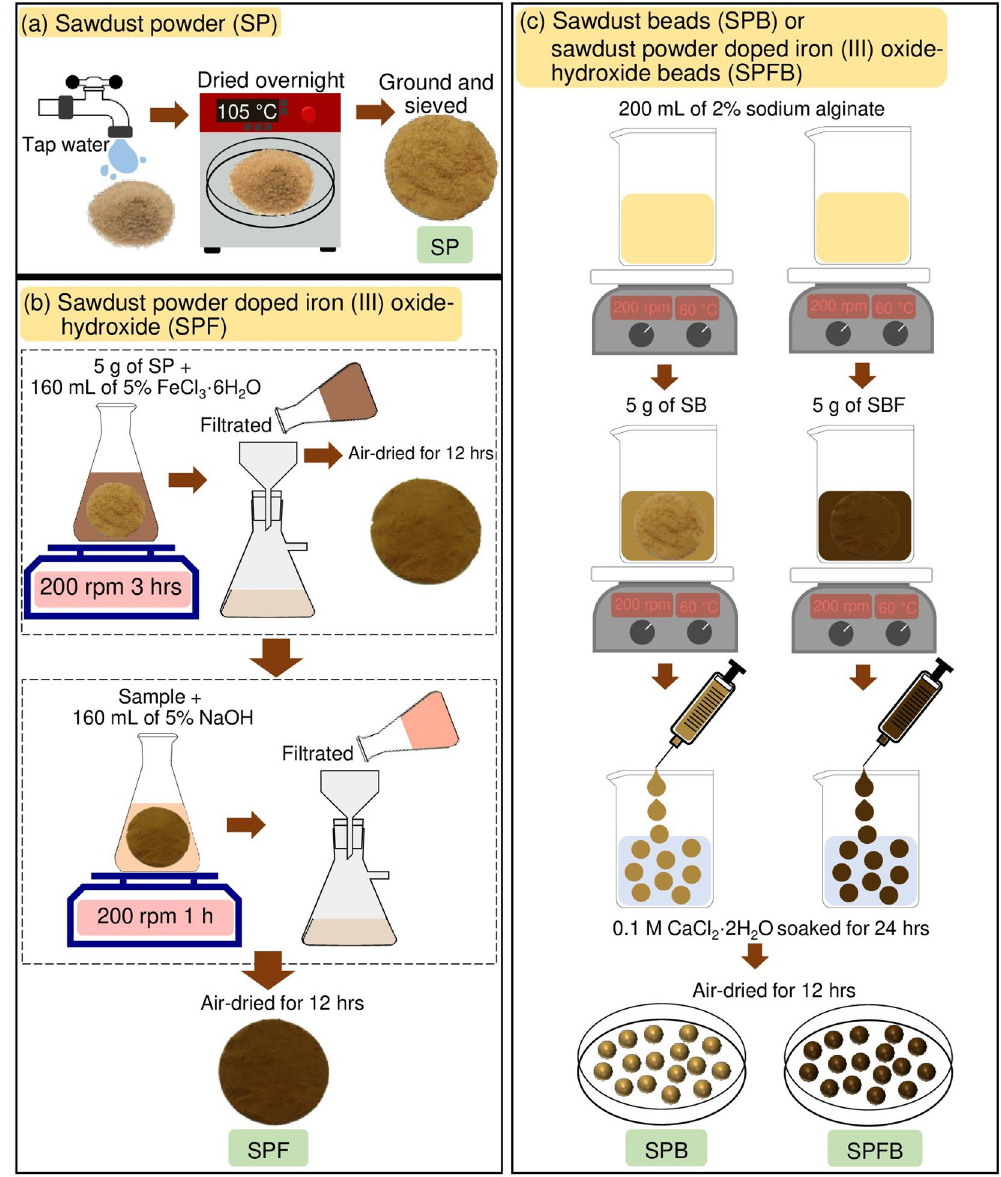
Figure 12. Flow diagrams of synthesis methods of ( a ) sawdust powder (SP), ( b ) sawdust powder doped iron (III) oxide-hydroxide (SPF), and ( c ) sawdust beads (SPB) and sawdust powder doped iron (III) oxide-hydroxide beads